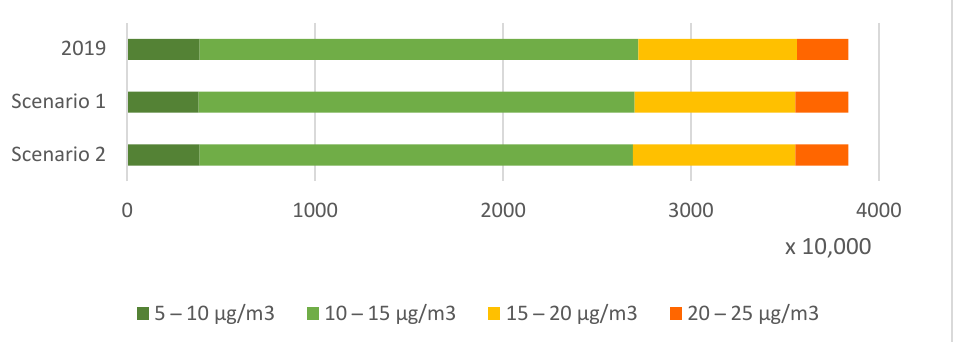
Table 4. Estimated number of premature deaths nationally due to annual average PM2.5 concen- trations in 2019 and based forecasts on scenario 1 and scenario 2.